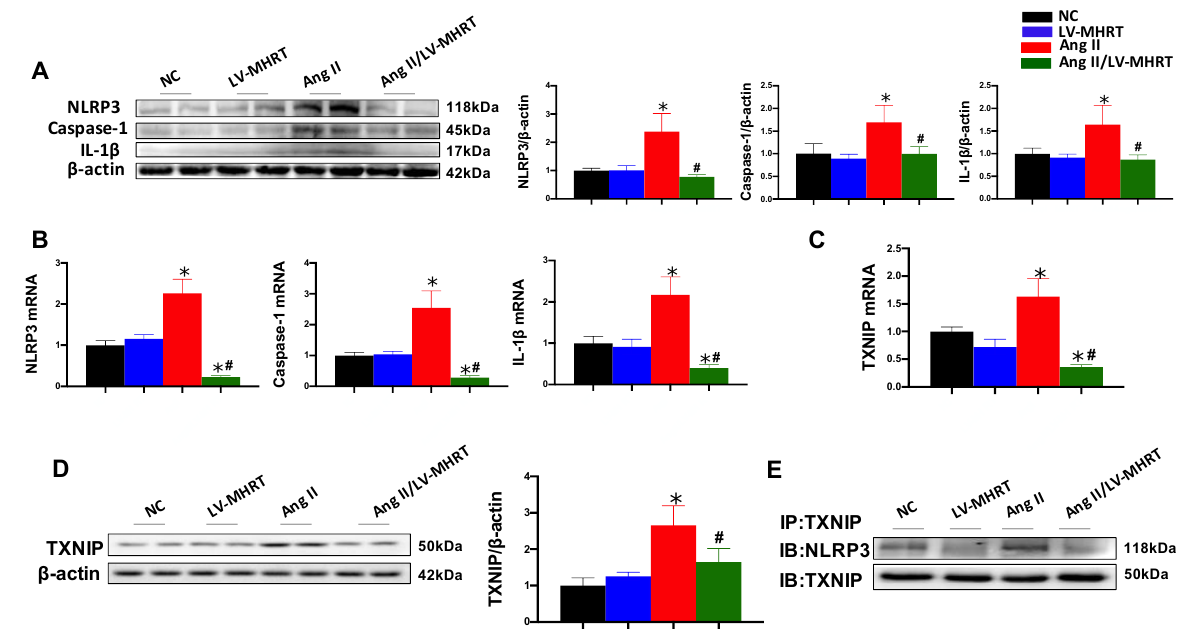
Figure 6. Overexpression of MHRT inhibits Ang II-induced NLRP3 inflammasome activation in AC16 cells. Cells were treated as described in Figure 5. The expression of NLRP3, caspase-1 and IL-1 β was evaluated by Western blot ( A ) and qPCR ( B ). The transcription and protein expression of TXNIP was detected by qPCR ( C ) and Western blot ( D ). The binding of TXNIP with NLRP3 was detected by Co-IP ( E ). Data are presented as the mean ± SD ( n = 6). * p < 0.05 vs.NC, # p < 0.05 vs. Ang